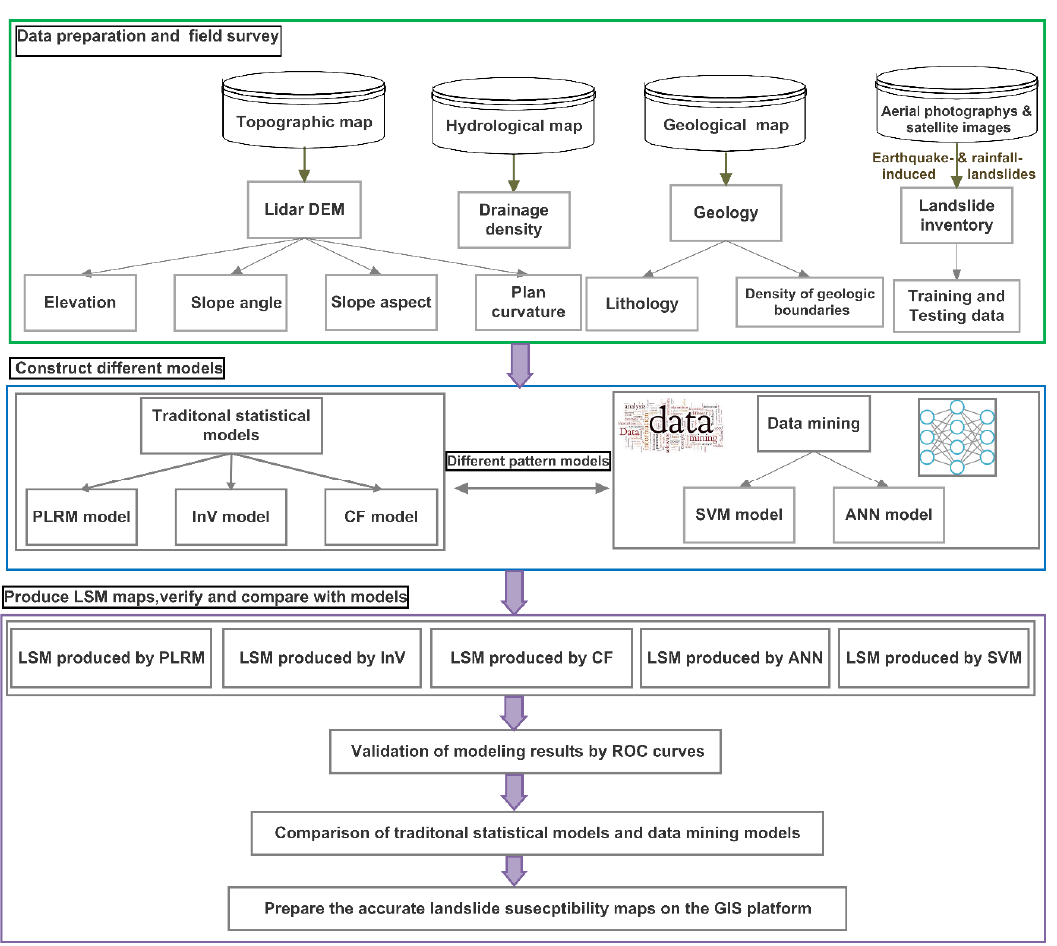
Figure 3. Framework for landslide susceptibility mapping (LSM) maps in the study.